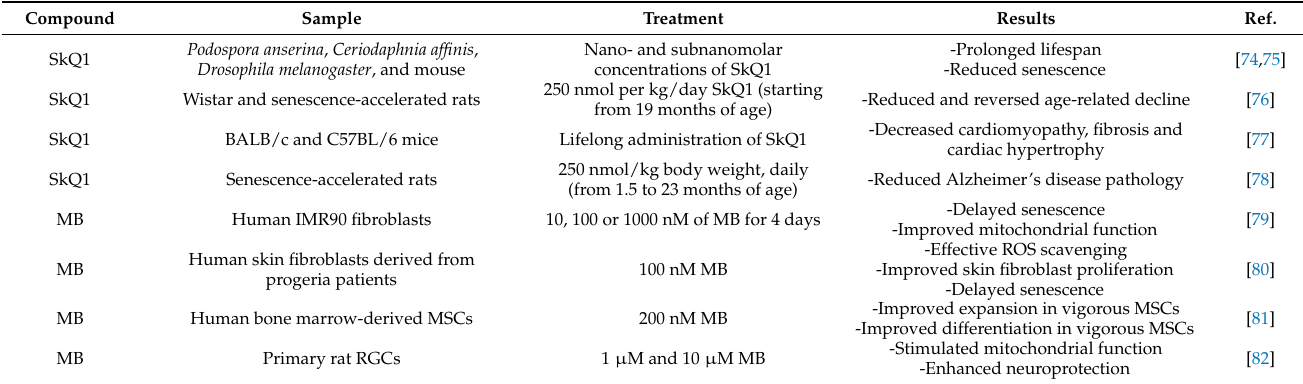
Table 2. SkQ1 and MB in the prevention of OS-induced